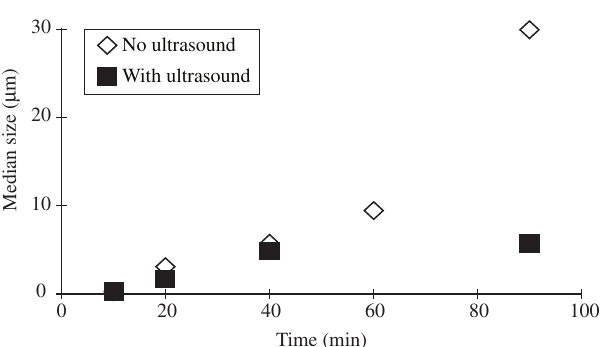
Figure 1. Median size of copper particles produced in Test 11, along the reaction time.